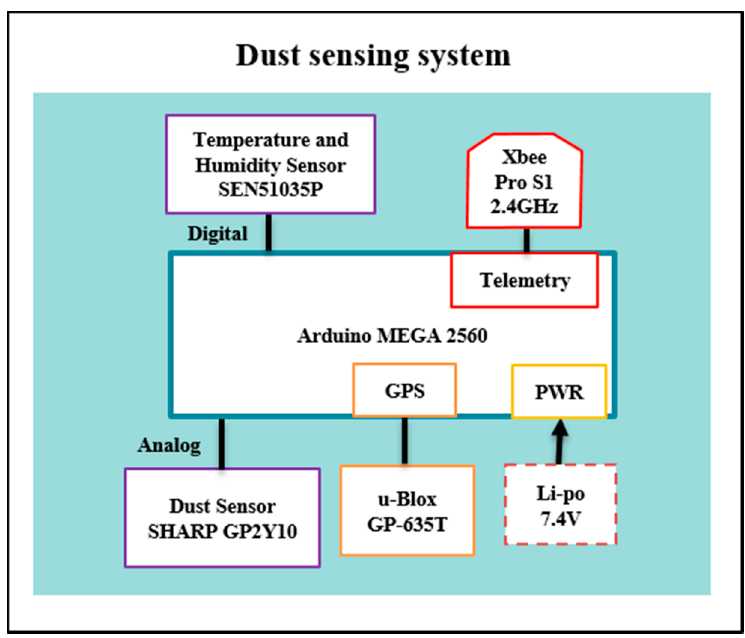
Figure 2. System architecture for the modular dust sensor.